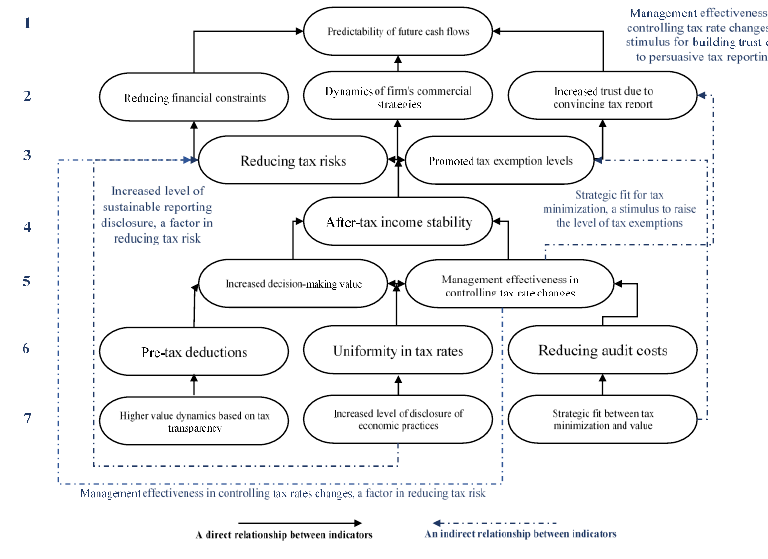
Figure 2: Design of a stratified model of tax sustainability development indices under the conditions of the information